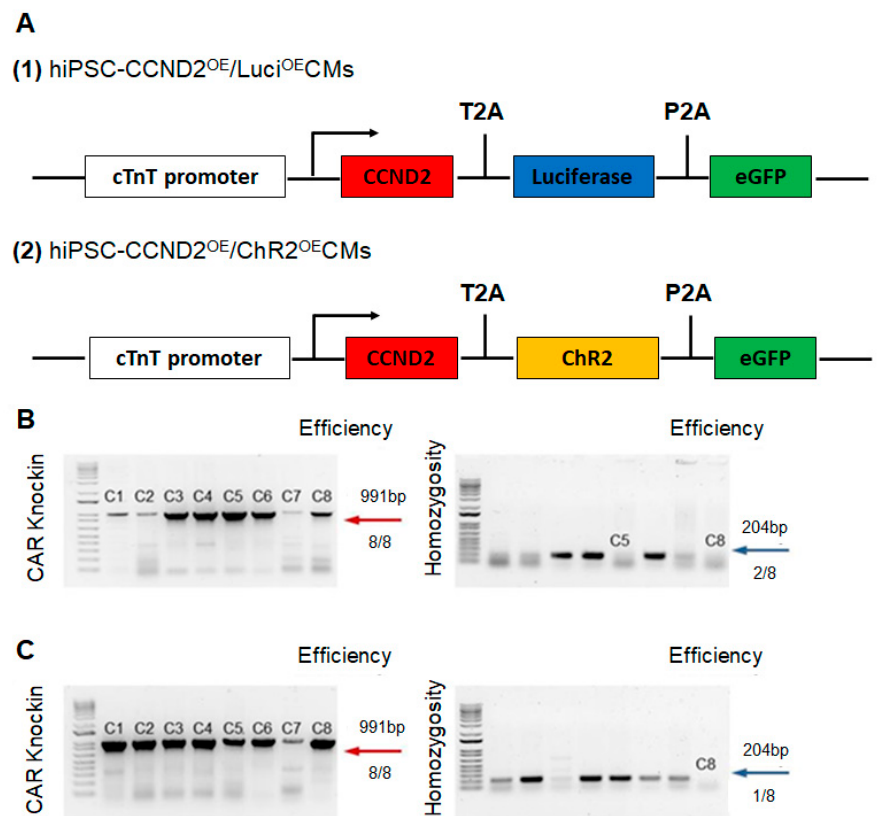
Figure 1. CRISPR-Cas9 based approach for targeted transgene knock-in to the hiPSC line. ( A ) Maps of the cTnT-CCND2-T2A-Luciferase-P2A-eGFP and cTnT-CCND2-T2A-Channelrodpsin 2-P2A-eGFP constructs are illustrated. ( B ) PCR genotyping of AAVS1 cTnT CCND2 ChR2 eGFP-engineered 19-9-7 hiPSC clones after puromycin selection is shown, and expected PCR product for correctly targeted AAVS1 site is 991 bp (red arrow) with an efficiency of 8 clones from a total of 8. A homozygosity assay was performed on the knock-in clones, and those without ~240 bp PCR products were homozygous (blue arrow). ( C ) PCR genotyping of AAVS1 cTnT CCND2 Luciferase eGFP-engineered 19-9-7 hiPSC clones after puromycin selection is shown, and expected PCR product for correctly targeted AAVS1 site is 991 bp (red arrow) with an efficiency of 8 clones from a total of 8. A homozygosity assay was performed on the knock-in clones, and those without ~240 bp PCR products were homozygous (blue arrow).